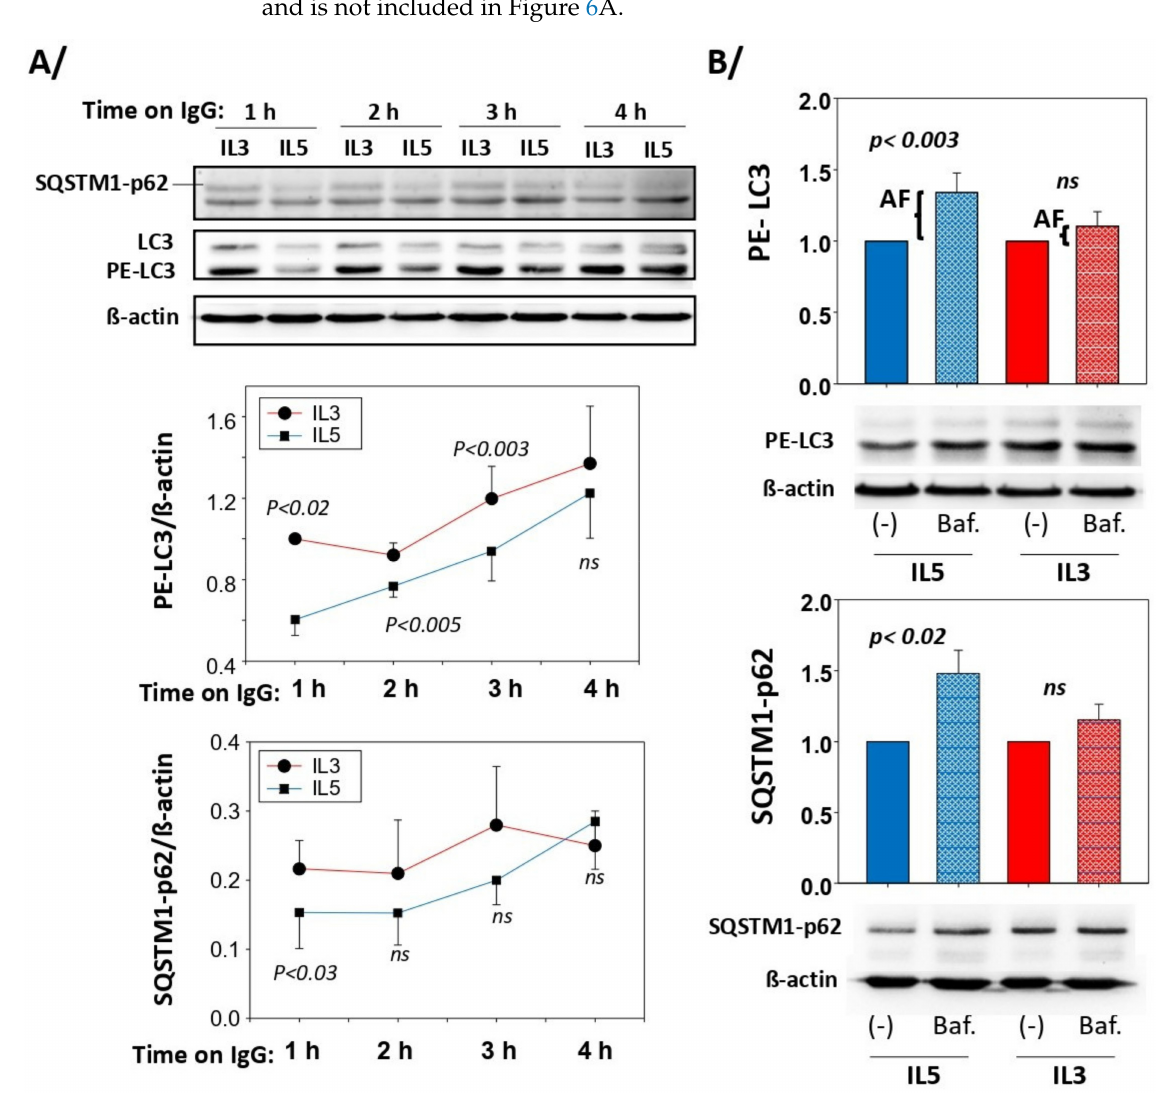
Figure 3. Autophagy is higher in IL5- versus IL3-primed eosinophils. Blood eosinophils were primed with IL3 (2 ng/mL) or IL5 (2 ng/mL) for 20 h and were seeded on coated HA-IgG for the indicated timepoints. Western blots for SQSTM1 and LC3 were performed and β -actin was used as a loading control. Representative blots and graphs with average ± SEM are shown. ( A ) The amount of PE-LC3 and SQSTM1-p62 was lower in IL5-primed versus IL3-primed eosinophils when interacting with IgG ( n = 3 experiments using 3 different donors). For each timepoint, paired Student’s t tests to compare IL3 and IL5 were performed and p values < 0.05 are shown (ns = not significant). ( B ) Western blots were performed to measure PE-LC3 and SQSTM1-62 in cytokine-primed (IL3 or IL5) eosinophils on IgG for 1.5 h after treatment with bafilomycin-A1 (Baf.; 1 µ M) or DMSO (vehicle only; (-)). The difference in amount of PE-LC3 with Baf. and vehicle only represent the autophagic flux (AF). Values for (-) were fixed at 1. Paired Student’s t tests were performed to evaluate the difference between Baf. and vehicle only (-). P values are shown; n = 6 experiments (6 subjects) for PE-LC3B and n = 7 (7 subjects) for